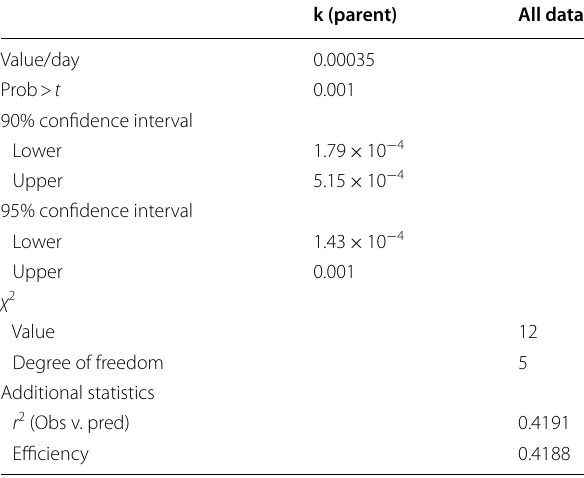
Table 3 Detailed results of kinetic modelling